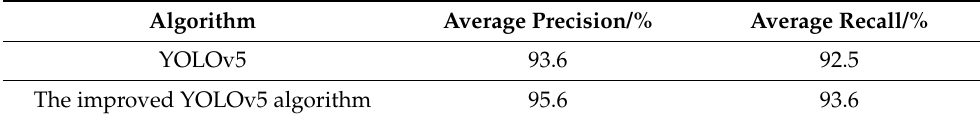
Table 8. Recognition results of improved YOLOv5 Algorithms with